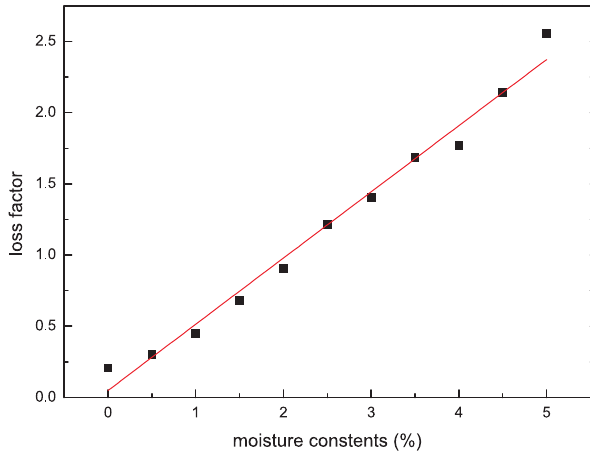
Fig. 5: Variation of loss factor of sodium chloride as a linear function of moisture content at 2.45 GHz